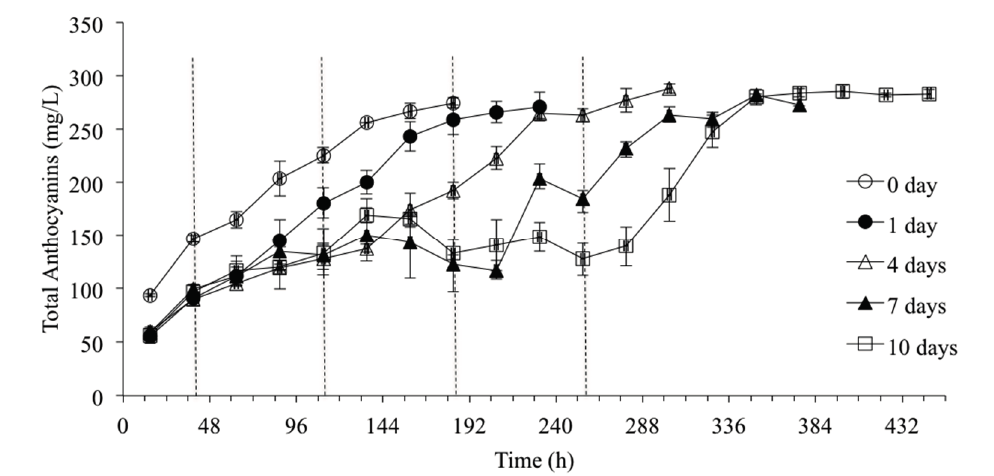
Figure 2. Total anthocyanin concentration in treatments with different CS durations during CS period and active fermentation, as determined by RP-HPLC (n = 3). The end of CS for 1, 4, 7, and 10 days of CS treatment are marked by a dashed line at 39, 111, 183, and 255 h,